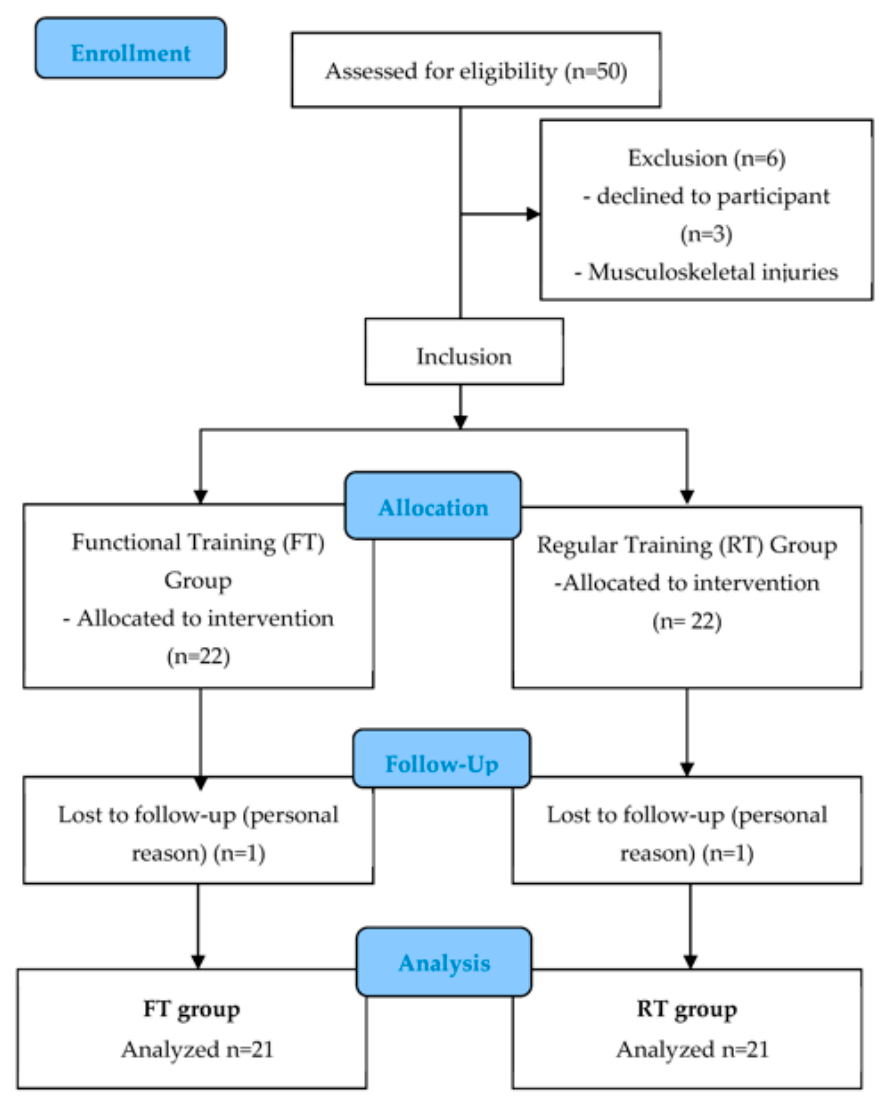
Figure 1. Flow chart of the experiment